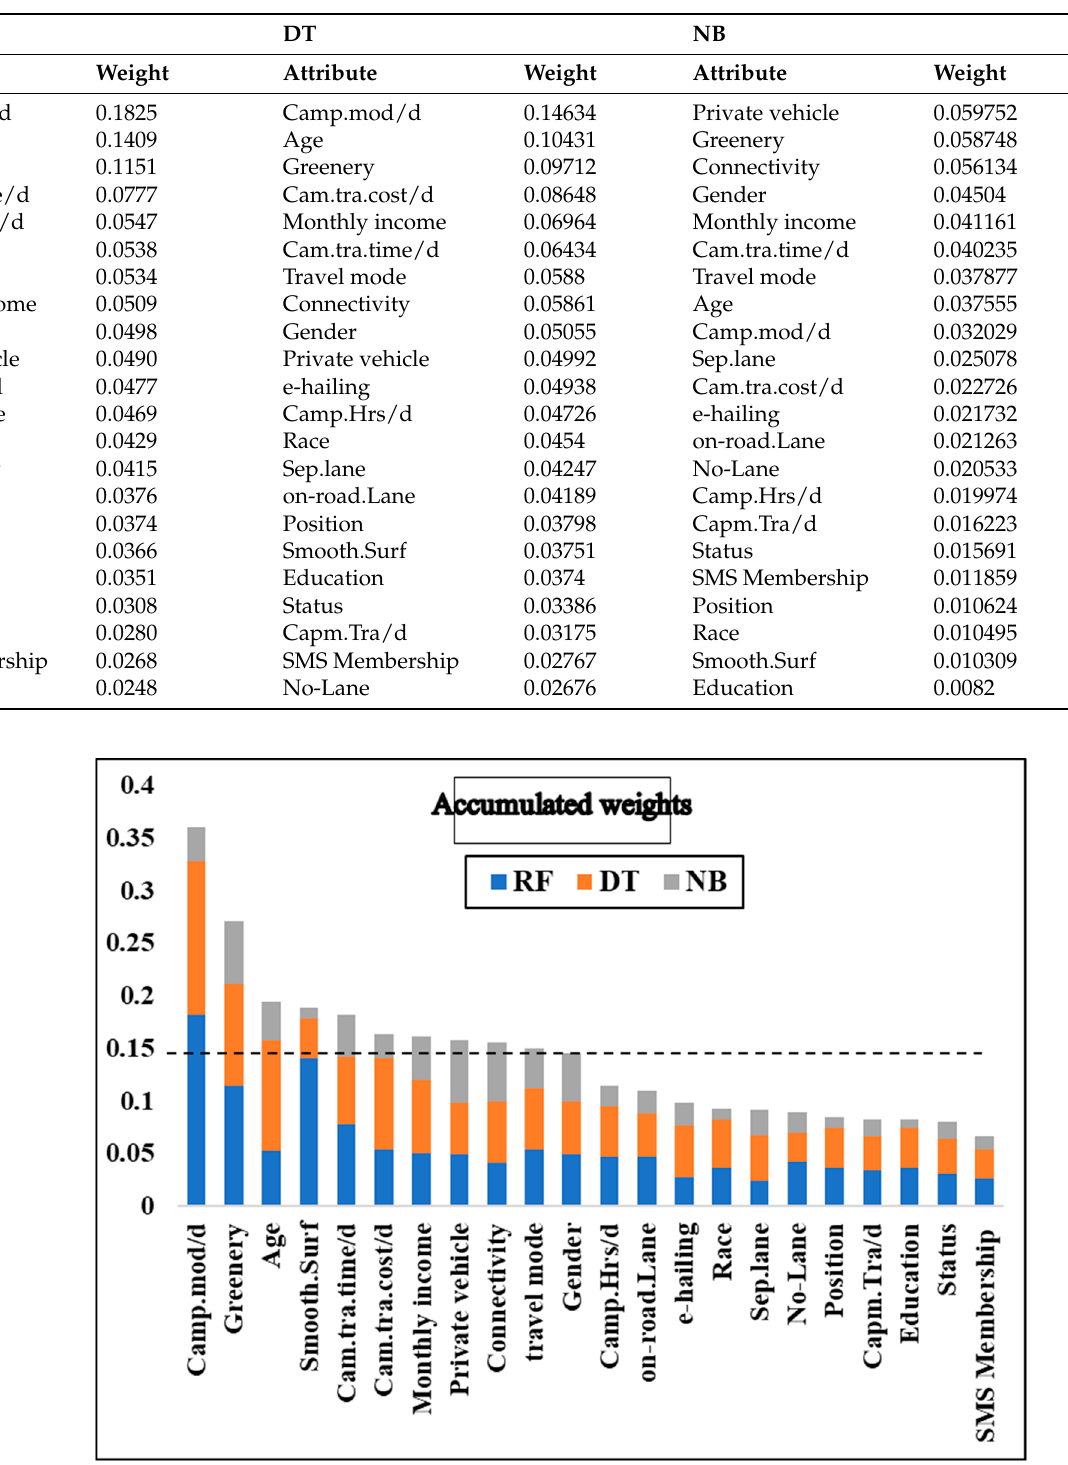
Figure 12. Accumulated weights of variables. Table 4. Importance of 11 selected variables based on feature selection